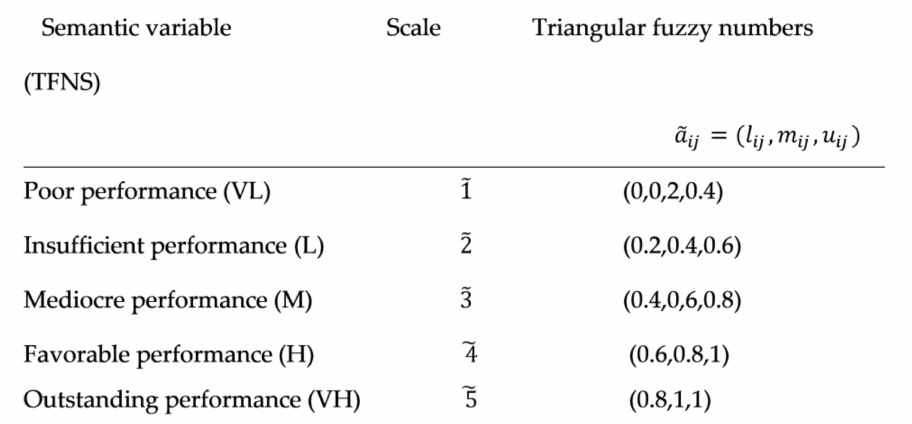
Figure 9. Relationships between semantics and triangular fuzzy numbers.